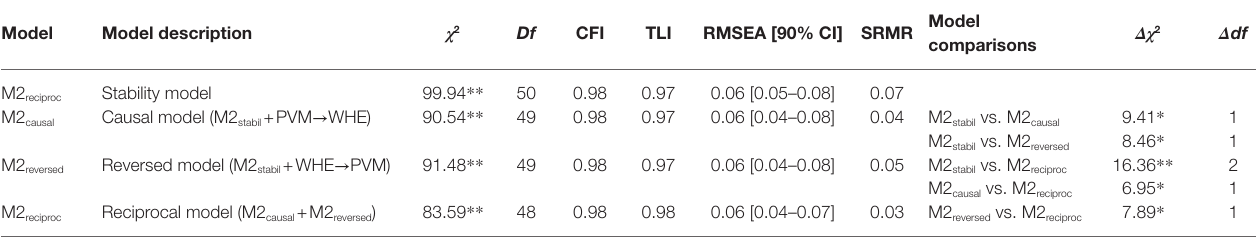
TABLE 4 | Fit statistics for the cross-lagged structural models between proactive vitality management and work–home enrichment.